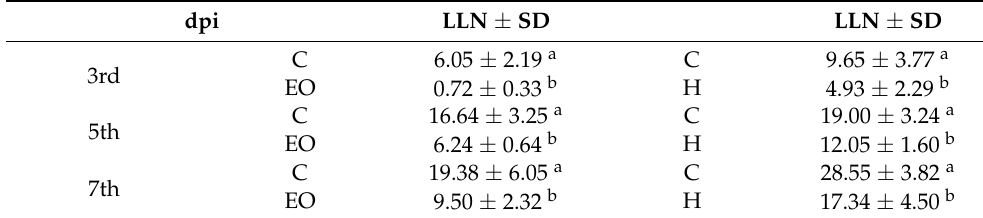
Table 3. Number of local lesions (LLN) on leaves of treated host plants inoculated with tobacco mosaic virus and on leaves of control plants (C) on days 3, 5, and 7 postinoculation (dpi). Prior to inoculation, treated plants were sprayed with essential oil (EO) or hydrosol (H) of H. perforatum ssp. veronense for two consecutive days. SD, standard deviation of triplicate analysis; significant differences were determined by t -test. a , b Mean values with different superscripts indicate statistically significant difference between control and essential oil/hydrosol treatment data ( p <